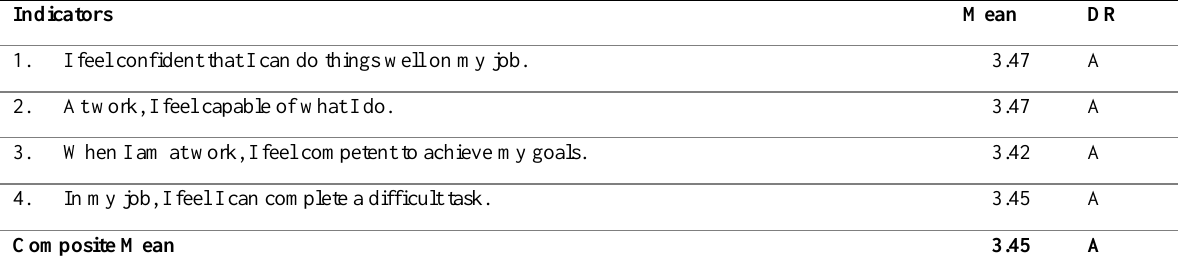
Table 4: Workplace Well-being of Divine Word Colleges in the Ilocos Region as to Competence Needs Indicators Mean DR